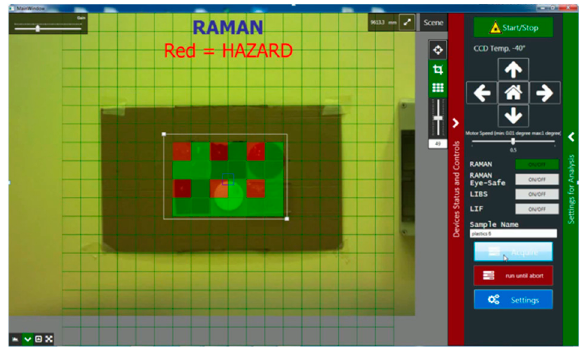
Figure 4. User interface photographed after Raman scanning of six plastic materials, each one containing an ammonium-nitrate fingerprint in the upper left corner. The largest area of the desktop is occupied by the image (video) acquired by the external camera. Fingerprints containing ammonium-nitrate were identified in real time, producing a red-colored cell in correspondence with its position on the target.